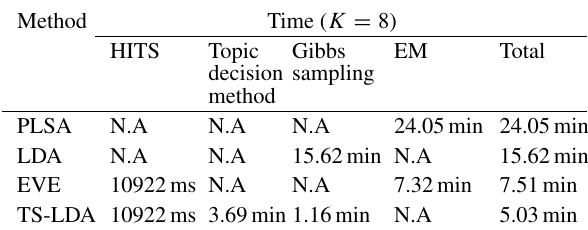
Table 5 Comparison of time